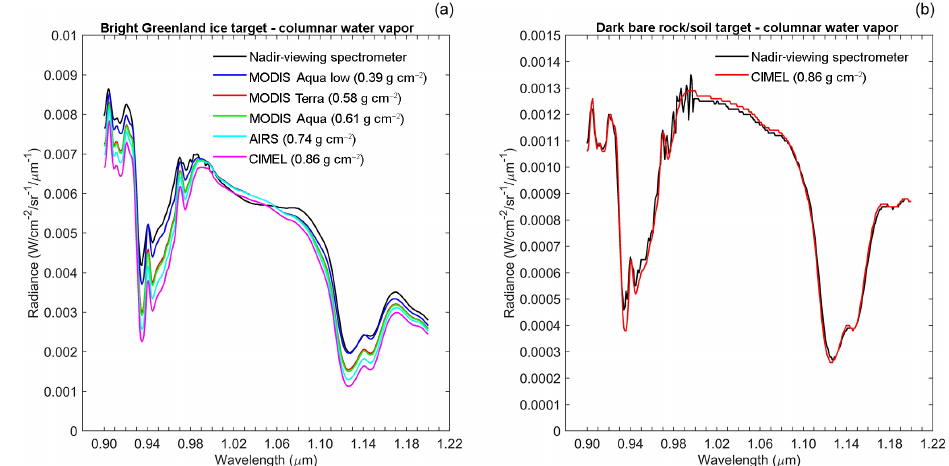
Figure 11. The airborne nadir-viewing spectrometer’s measurement sensitivities to columnar water vapor for bright Greenland ice (a) and dark bare rock/soil (b) targets. A variety of satellite columnar water vapor data products were evaluated for the bright Greenland ice target due to the remoteness of the flight line segment and its proximity to the Thule Air Base CIMEL. Table 1. Input satellite and AERONET water vapor products for MODTRAN predictions of bright Greenland ice for the nadir-viewing spectrometer. Observing